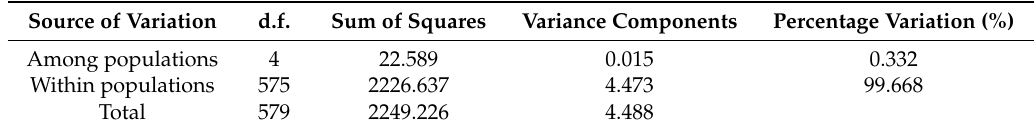
Figure 2. Correlation between genetic distance and geographic distance for cypress populations. Table 5. Analysis of molecular variance (AMOVA) within and among populations. Source of Variation d.f.